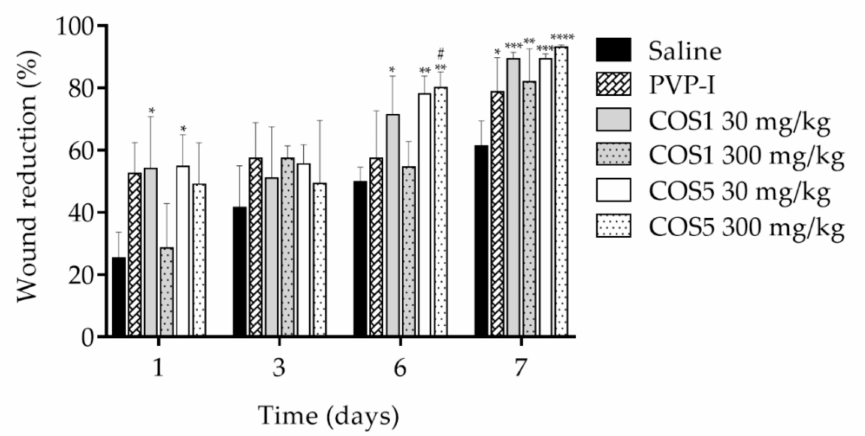
Figure 10. Skin wound extension for days 1, 3, 6, and 7 after local administration of doses of 30 or 300 mg/kg of COS1 or COS5. Note: * p < 0.05, ** p < 0.003, *** p < 0.001, and **** p < 0.0001 compared to the saline group; # p < 0.1 compared to the PVP-I